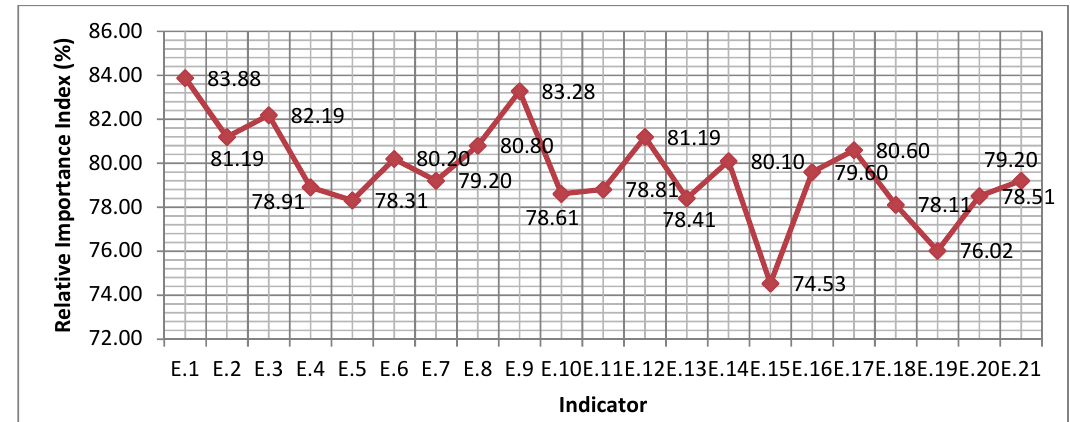
Fig. 2. Line chart of Relative Importance Index (RII) for CSFs of KM